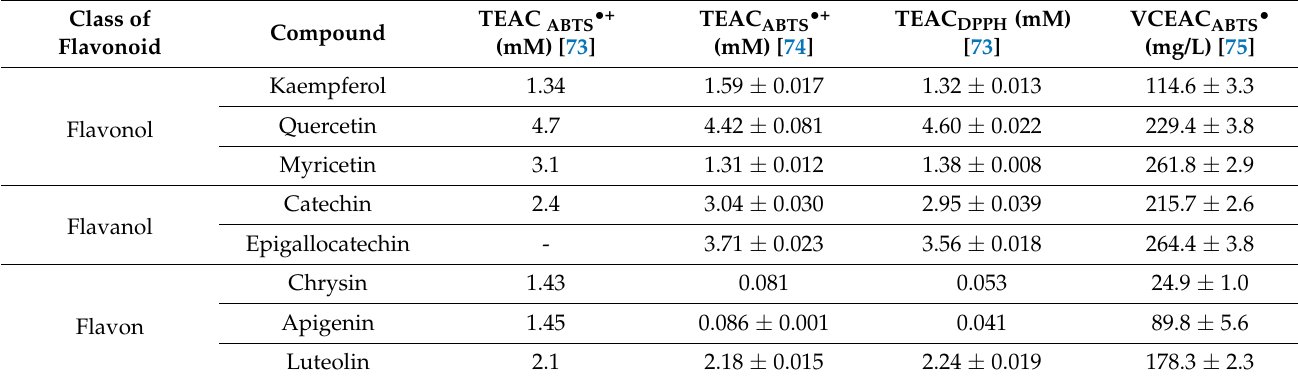
Table 1. Flavonoids classified according to the increasing number of hydroxyl groups within the class together with the assignment of experimentally determined values of TEAC ABTS • , TEAC DPPH • , and VCEAC ABTS • . Based on [73–75]. Class